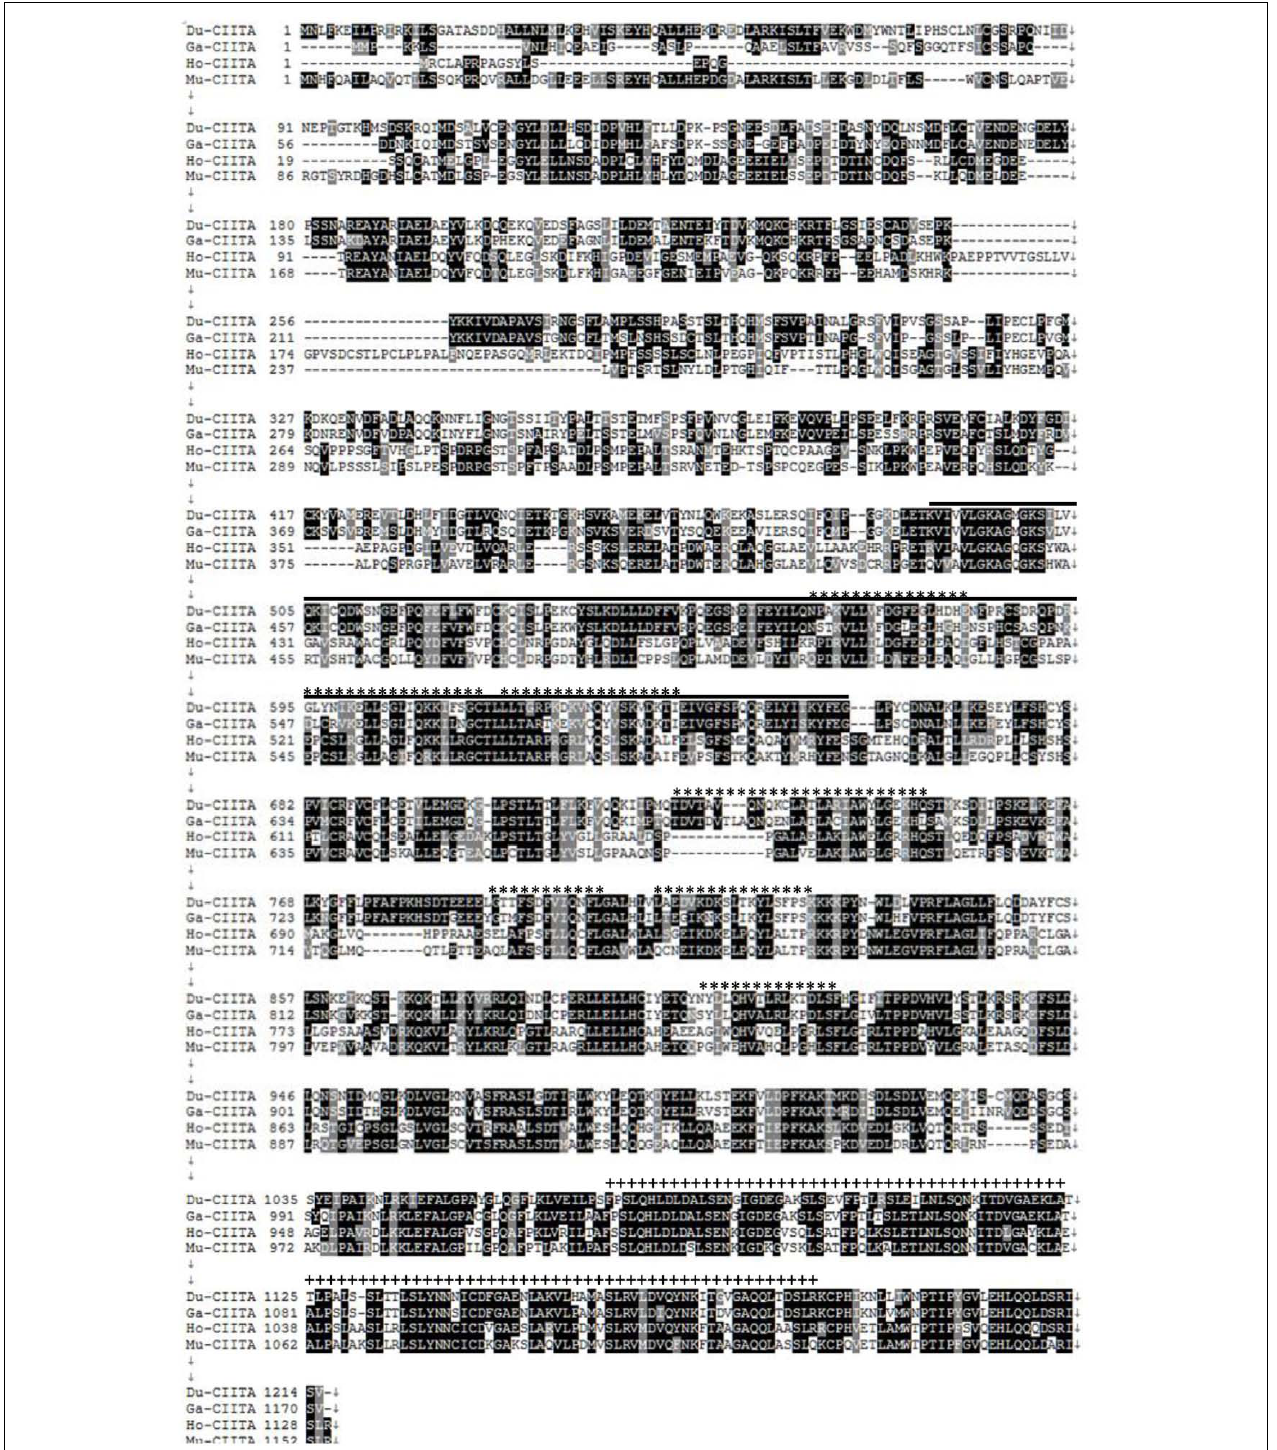
FIGURE 1 | Multiple alignment of the Cherry Valley ducks CIITA. Alignment was performed using the Clustal X program and edited with Boxshade. The CIITA sequences are shown for Cherry Valley duck (Du), chicken (Ch), human (Hu), and mouse (Mu). The amino acid sequences used are seen in Table 2 . Black shading indicates amino acid identity; gray shading indicates similarity (50% threshold); the black line represents the NACHT domain; the ∗∗∗ above the sequence represents the seven predicted transactivator domains; the +++ above the sequence represents the four LRR domains.